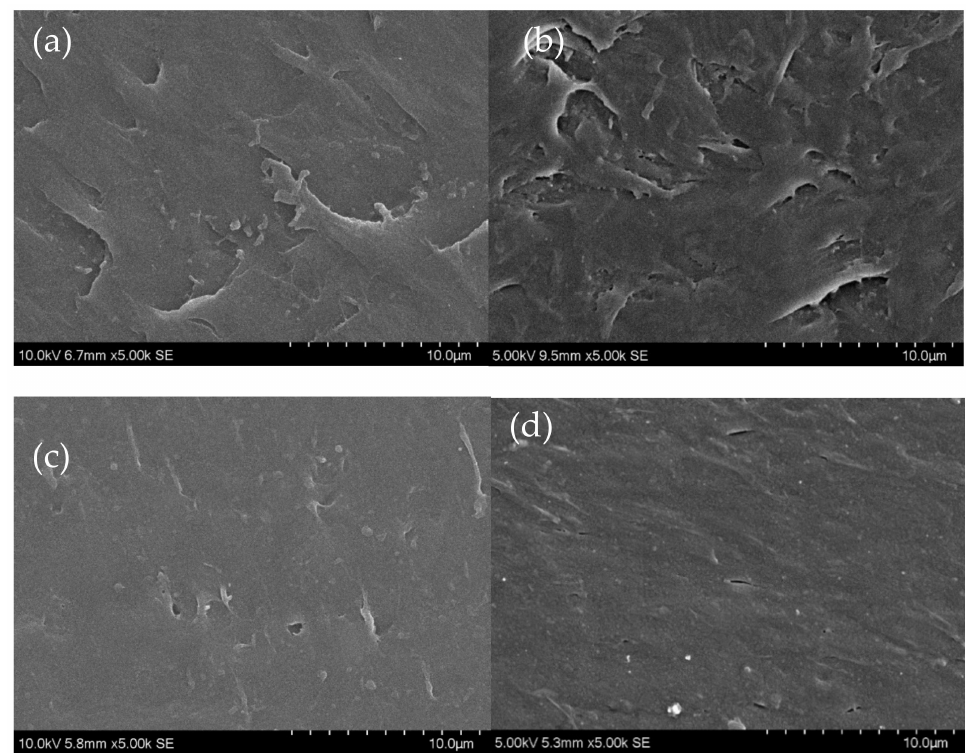
Figure 6. ( a ) The surface of the 0.1 wt% mica/polypropylene composite, ( b ) the surface of the 1 wt% mica/polypropylene composite ( c ) 0.5 wt% mica/0.01 wt% graphene oxide (GO)/polypropylene (PP) and ( d ) 0.5 wt% mica/0.05 wt% GO/PP SEM